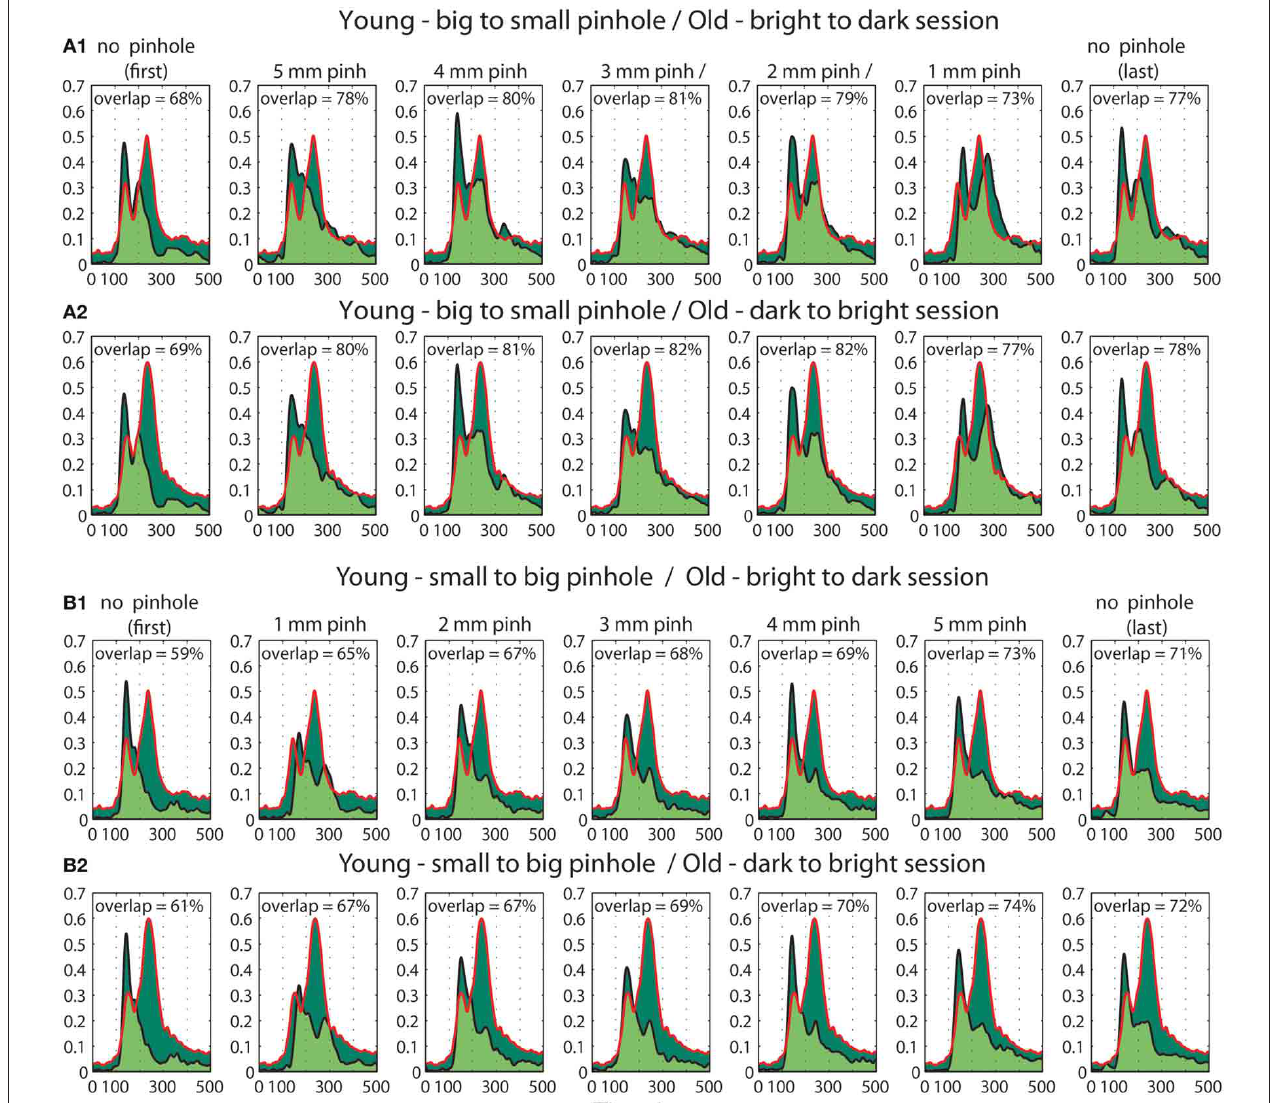
FIGURE 15 | Overlaps between t 2 functions of young subjects tested in the pinhole experiment and old subjects tested in the luminance experiment. (A) Overlap between old ( > 60) adults in the first brightest (60.8cd/m 2 ) condition from the b2d (A1) and d2b (A2) session of the luminance experiment and young subjects in all the pinhole conditions of the pinhole experiment’s b2s session. (B) Overlap between old subjects in the brightest (60.8cd/m 2 ) condition from the b2d (B1) and d2b (B2) session of